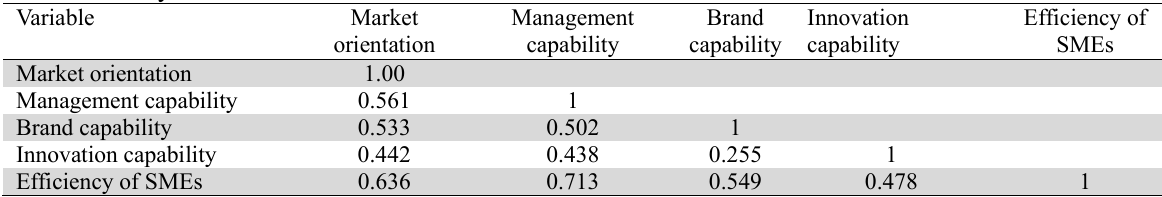
The summary of Pearson correlation